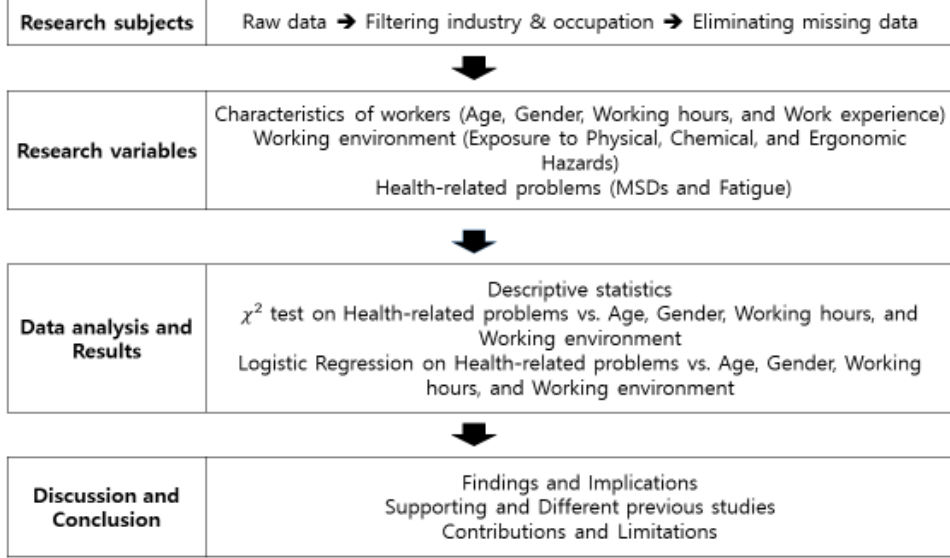
Figure 1. Research approach of this study.